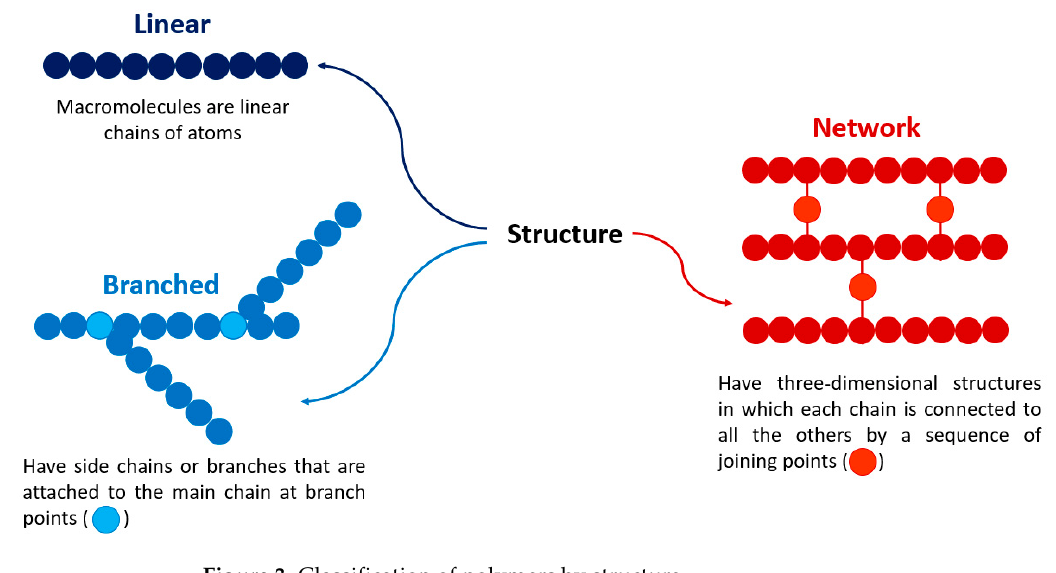
Figure 3. Classification of polymers by structure.